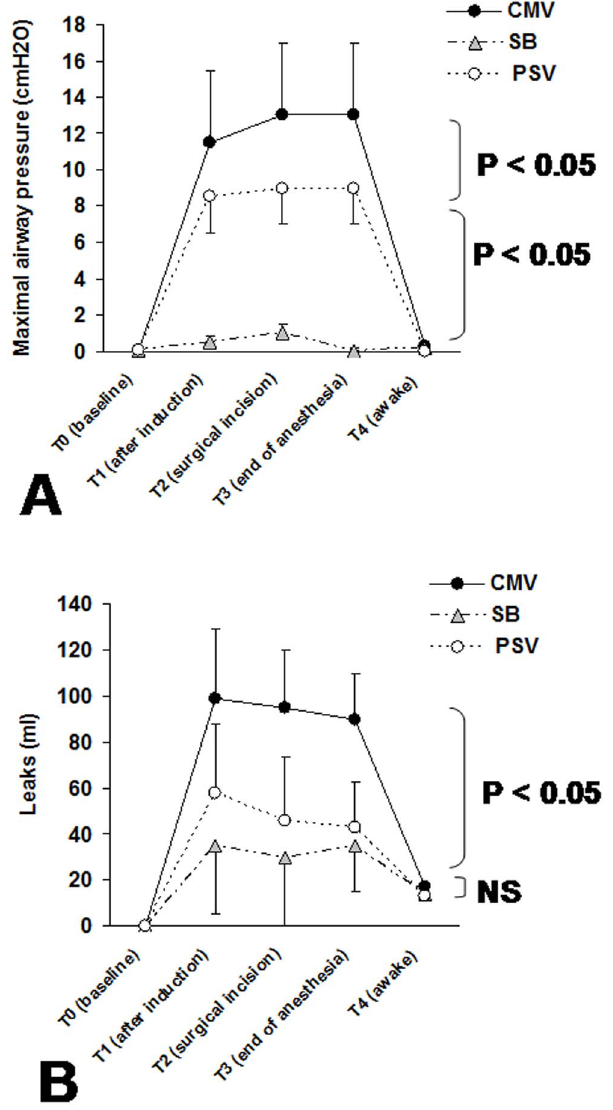
Fig. 5. Maximal airway pressure and leaks volume around the LMA. ( A ) Maximal airway pressure and ( B ) leaks volume around the LMA at baseline (T0: before general anesthesia induction), 10 min after general anesthesia induction (T1), at the surgical incision (T2), at the end of anaesthetic drugs infusion (T3) and when the patient was totally awake (T4) obtained for the three groups: CMV-group (Controlled Mechanical Ventilation), SB-group (Spontaneous Breathing) and PSV-group (Pressure Support Ventilation). Data are expressed as mean ¡ SD. P value refers to between-groups comparison. * P , 0.05 versus baseline values, NS: not